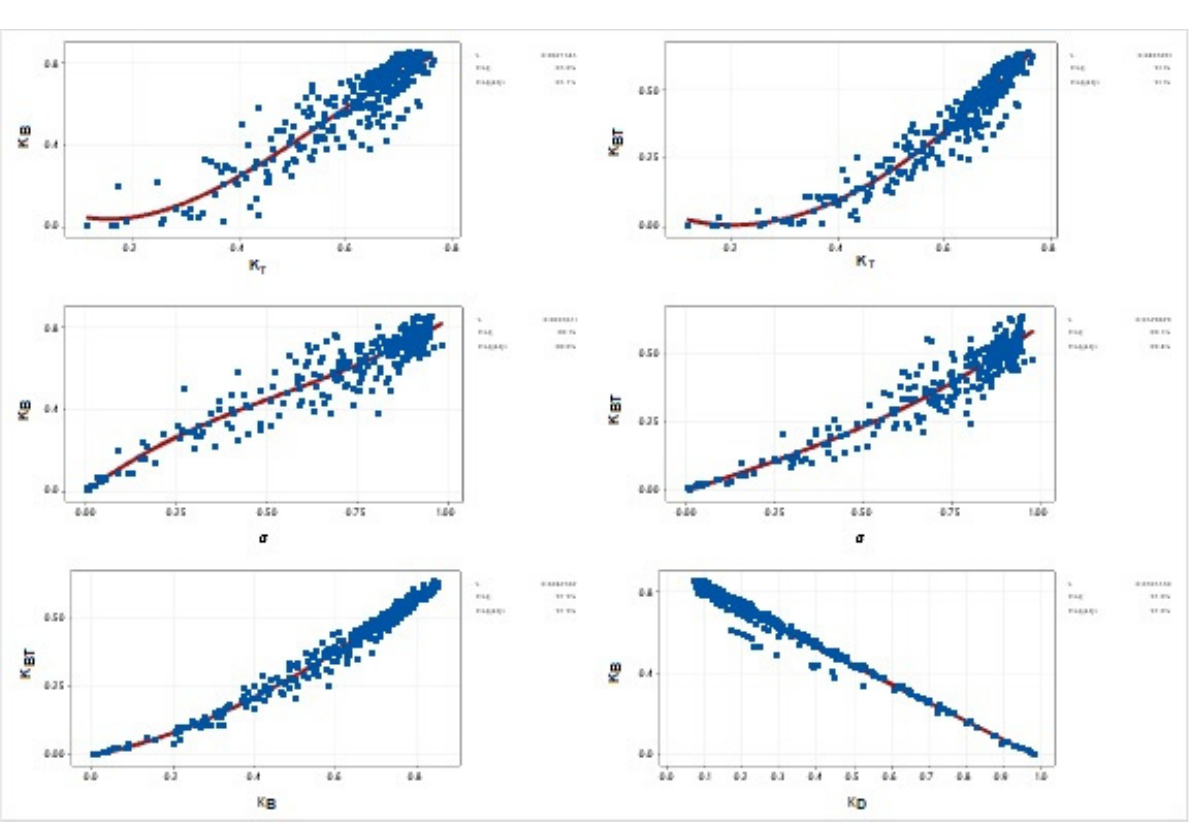
Figure 29. Relationships between various daily radiation